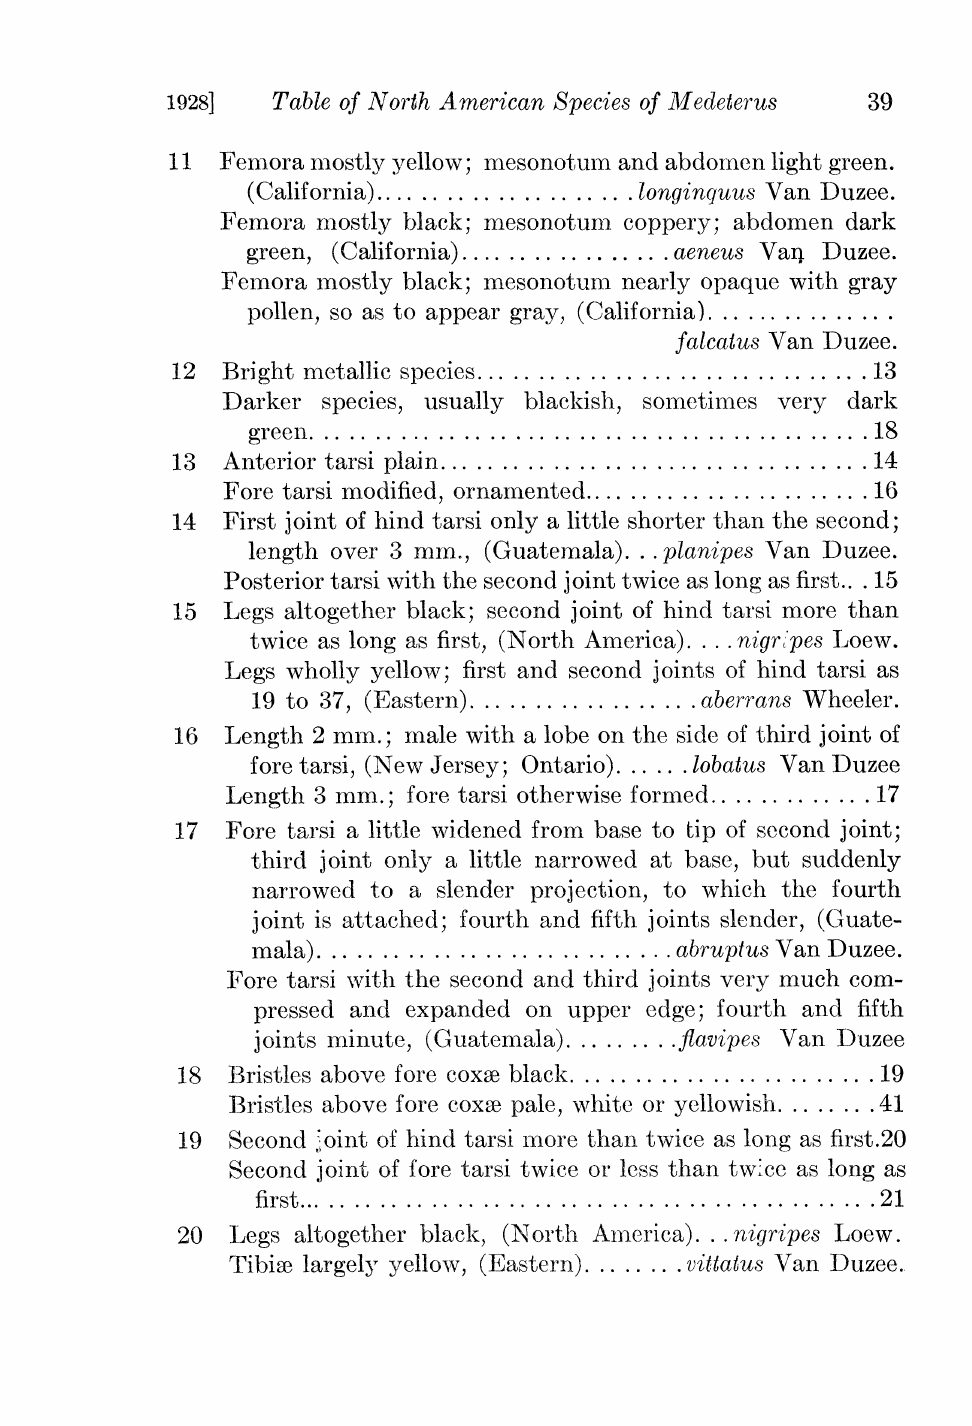
Table of North American Species of